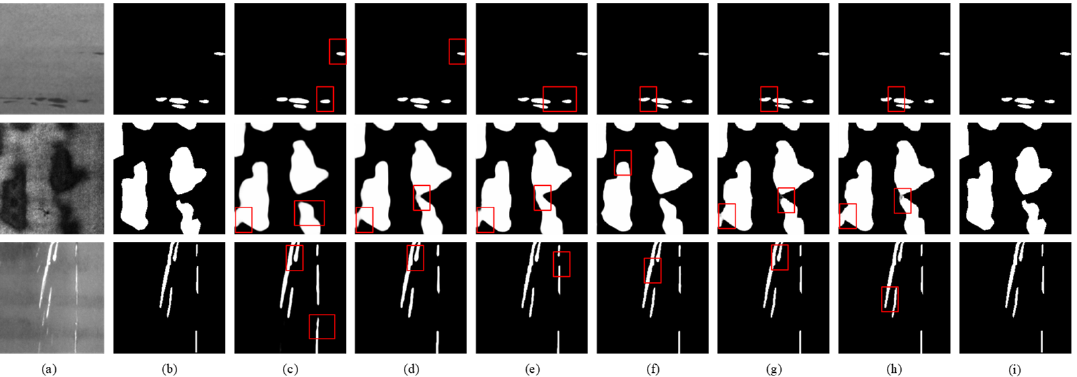
Figure 7. Visual comparison of saliency detection results under the models composed of the different key components. From left to right, as follows: ( a ) input image; ( b ) ground truth; ( c ) baseline (B); ( d ) B + attention; ( e ) B + URB; ( f ) B + URB + RN_1D; ( g ) NURCNet-URB*; ( h ) NURCNet-RN_1D*; ( i ) NURCNet.